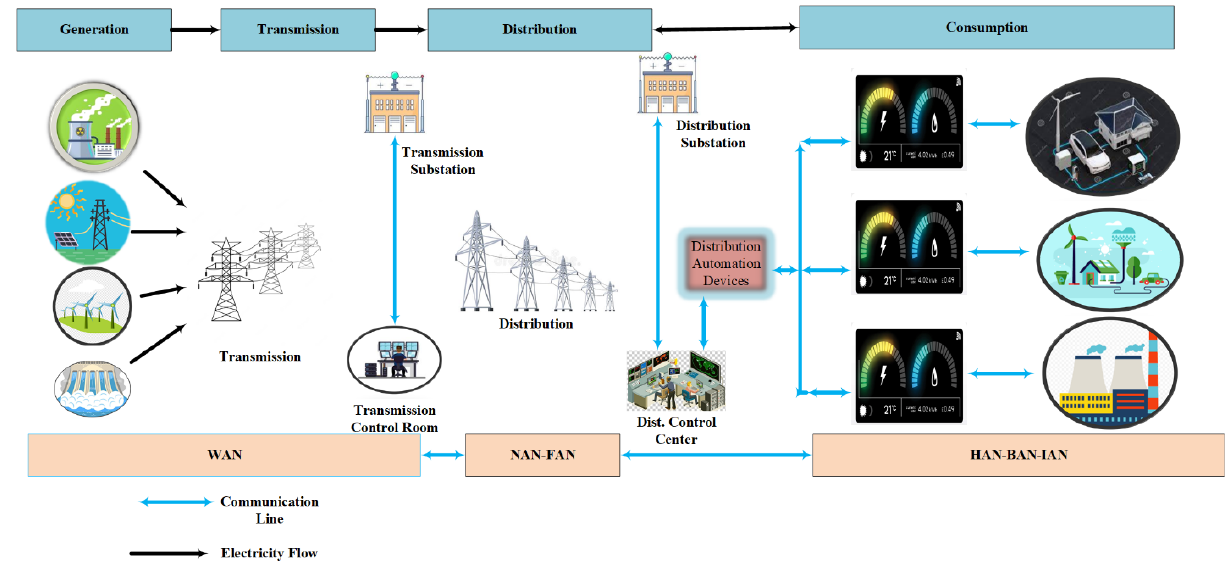
Figure 1. Smart Grid Infrastructure from Generation to Consumer end.